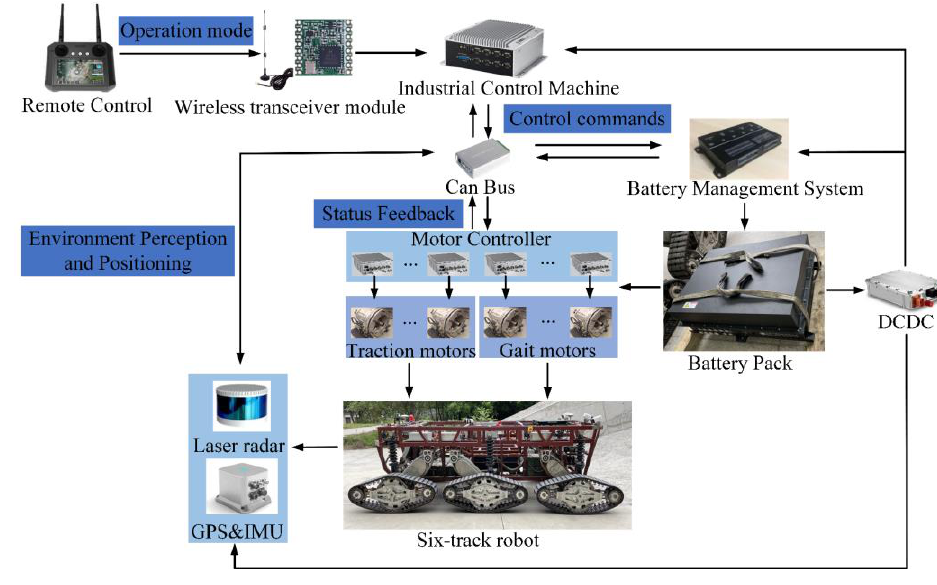
Figure 11. Six-track robot hardware block diagram.